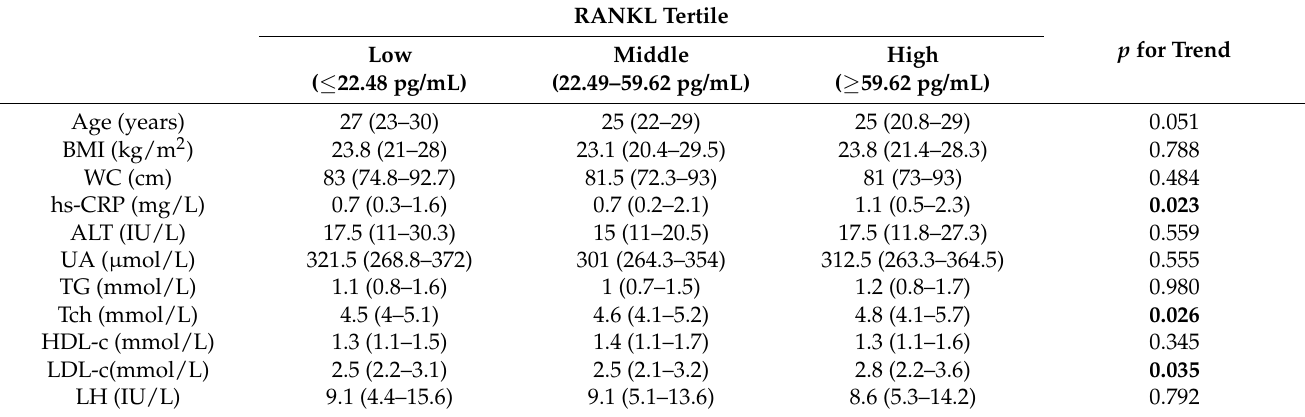
Table 2. Associations of RANKL levels with clinical variables of PCOS patients. RANKL